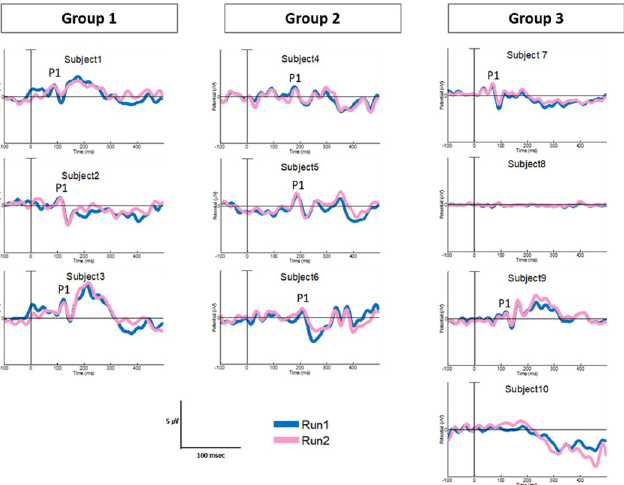
Fig 1. Individual cortical auditory-evoked potential in groups 1, 2, and 3. Each patient in all groups showed typical P1 with varying latencies, except the last two patients in group 3, who displayed anomalous (absent) P1 morphology.